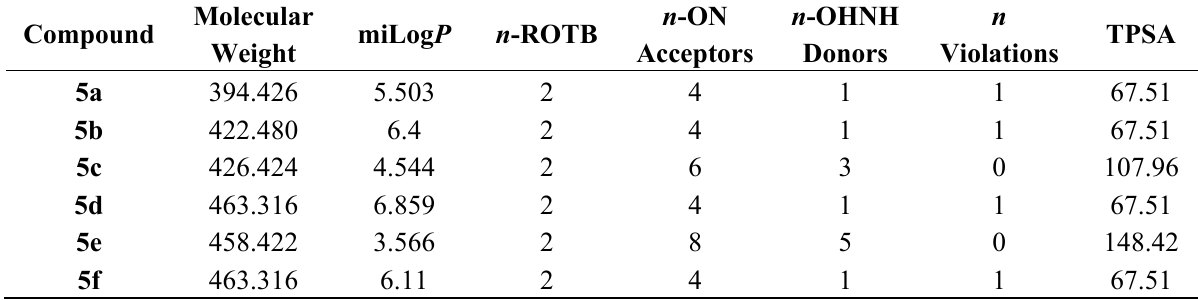
Table 3. Drug-likeness property/Lipinski’s ‘rule of five’ parameters calculated for xanthenediones ( 5 ) a